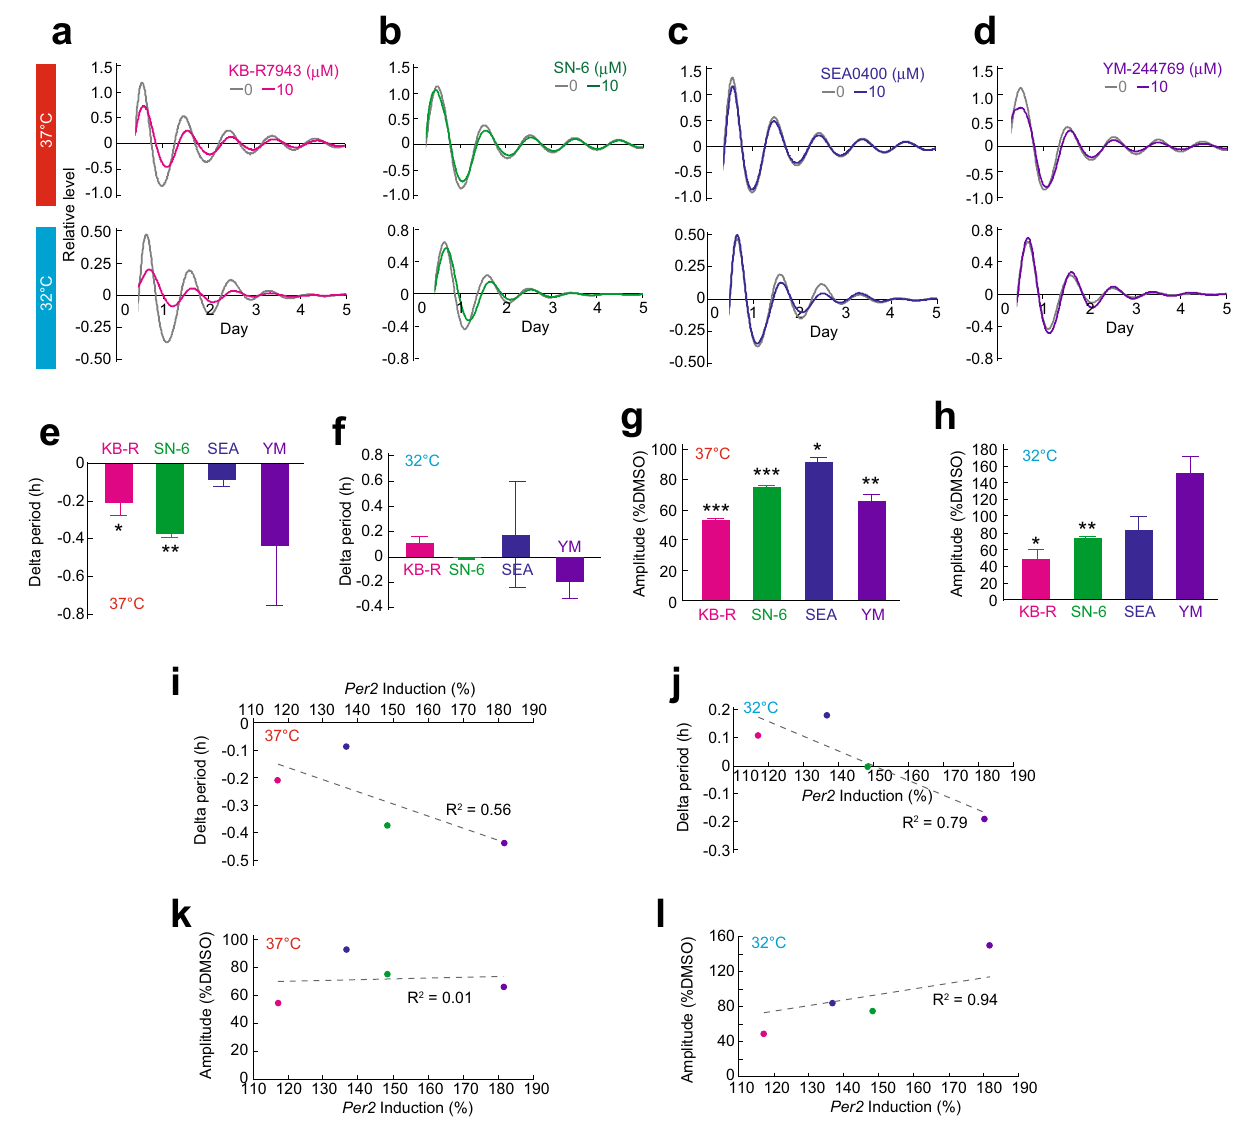
Figure 5. Correlation analysis between cold Per2 induction and circadian rhythm parameters. Representative data of the effect of KB-R7943 ( a ), SN-6 ( b ), SEA0400 ( c ), or YM-244769 ( d ) on relative bioluminescence rhythms of Rat-1 Bmal1 -luc cells. Effects of 4 NCX inhibitors on period length of bioluminescence rhythms at 37 °C ( e ) or 32 °C ( f ). Effects of 4 NCX inhibitors on amplitude at 37 °C ( g ) or 32 °C ( h ). Correlation analysis of cold Per2 induction and period length at 37 °C ( i ) or 32 °C ( j ). Correlation analysis of cold Per2 induction and amplitude at 37 °C ( k ) or 32 °C ( l ). Mean with s.e.m. from 4 independent samples are shown ( e – h ). * p < 0.05, ** p < 0.01, *** p < 0.001 compared to the DMSO control (Student’s t-test, with Bonferroni correction). Mean from 4 independent samples are shown ( i – l